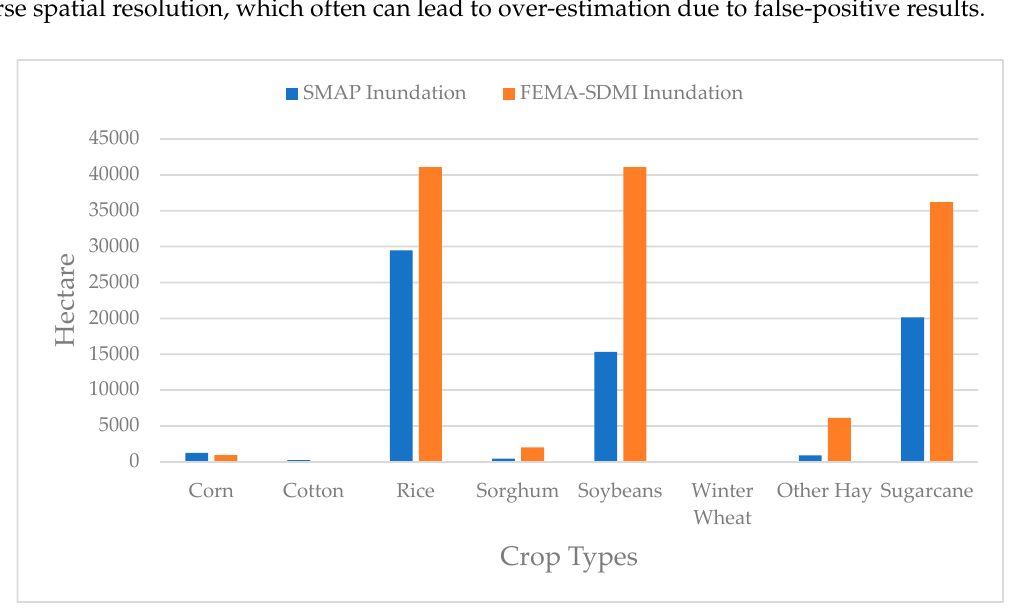
Figure 7. Comparison of SMAP and FEMA-SDMI derived inundation acreage of the Baton Rough Flood over major crop types.